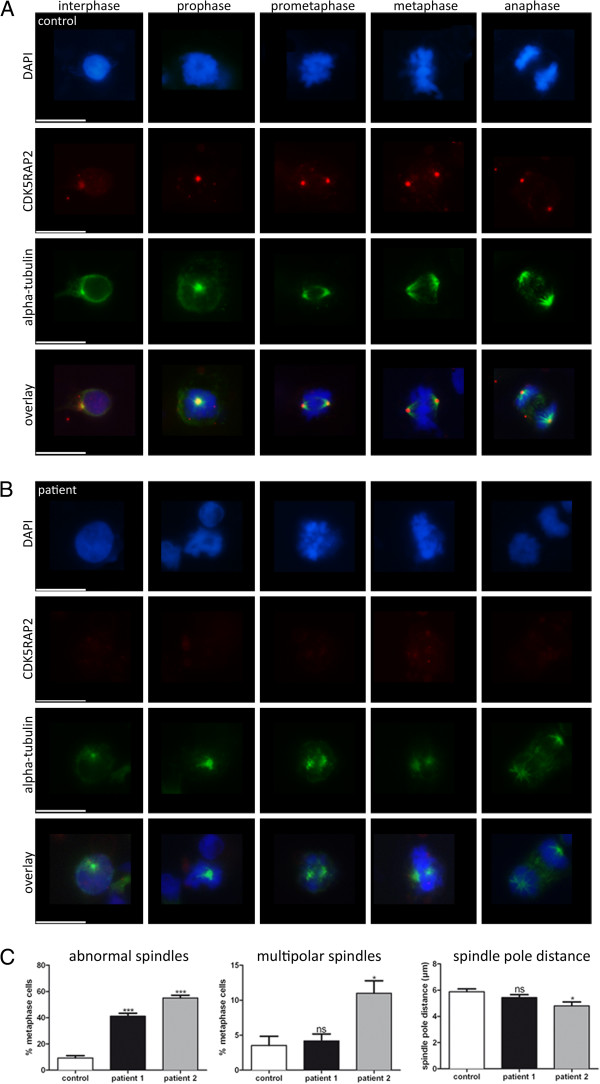
Spindle defects in CDK5RAP2 mutant patients cells. Subcellular localization of CDK5RAP2 and α-tubulin throughout the cell cycle in immortalized lymphocytes of (A) control and (B) MCPH3 patient 2. In controls, CDK5RAP2 is weak and centrosomal during interphase and shows abnormal spindle formation. In patients, spindle pole formation did not appear to be as precise as in the control cells, with the chromosomes not as uniformly positioned at the spindle poles. Cells were stained with CDK5RAP2 (red), α-tubulin (green) as a centrosomal marker, and DNA is stained with DAPI (blue). Scale bars 10 μm. (C) Quantification results of abnormal spindles (unfocused α-tubulin staining at spindle poles), multipolar spindles and spindle pole distance.